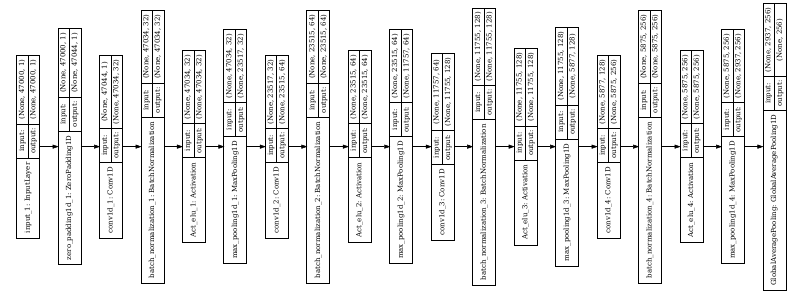
Figure 32: Stacked convolutional layers for